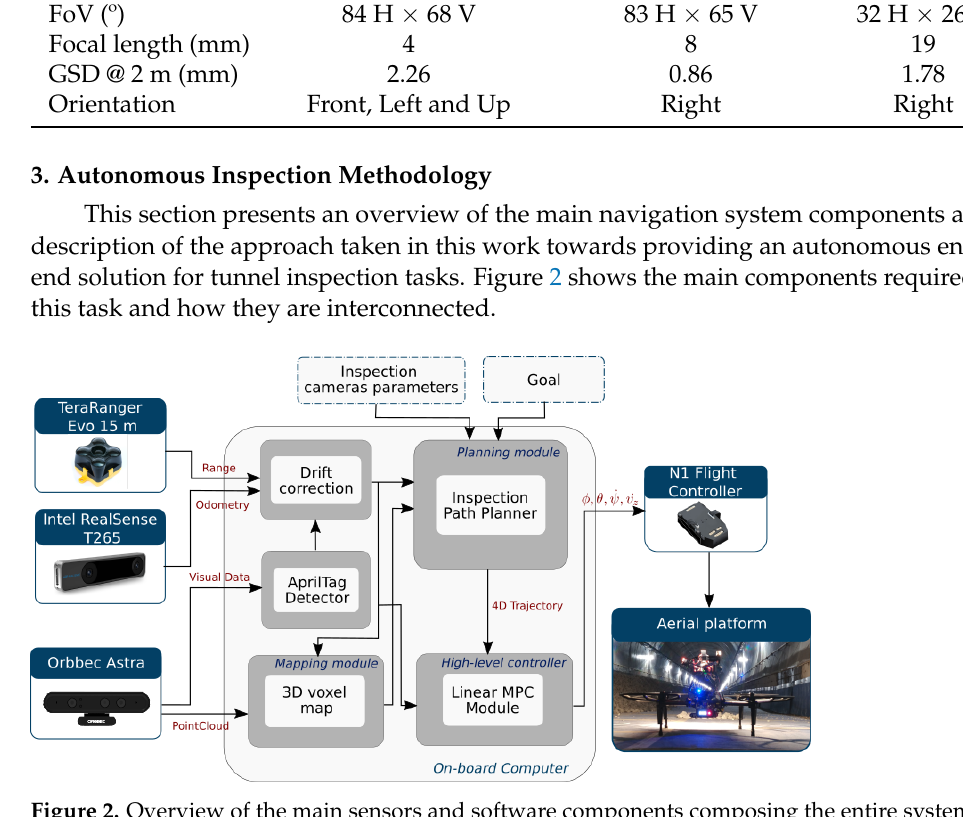
Figure 2. Overview of the main sensors and software components composing the entire